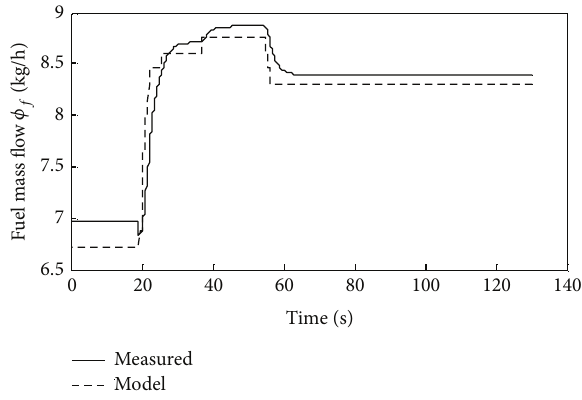
Figure 21: Measured and modeled results of fuel mass flow.